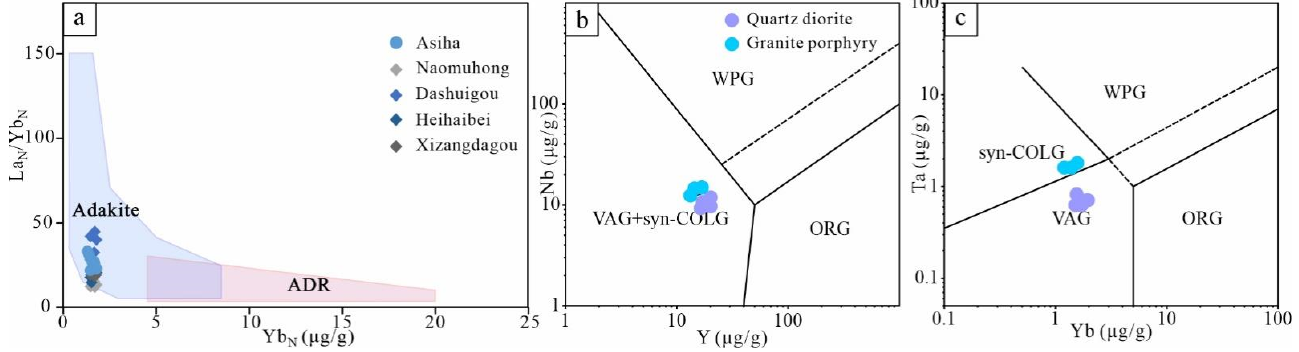
Figure 6. Discrimination diagrams for the granitoids origin, La N /Yb N vs. Yb N ( a ), Y vs. Nb ( b ), Yb vs. Ta ( c ). Data sources: Naomuhong, Dashuigou, Heihaibei, Xizanggdagou after [47]. ADR = Andesite, dacite, and rhyolite field, VAG = volcanic-arc granites, WPG = within plate granites, ORG = oceanic ridge granite, and syn–COLG = syn–collision granite. Figure 6a is modified from [48]; Figure 6b,c are modified from [49].